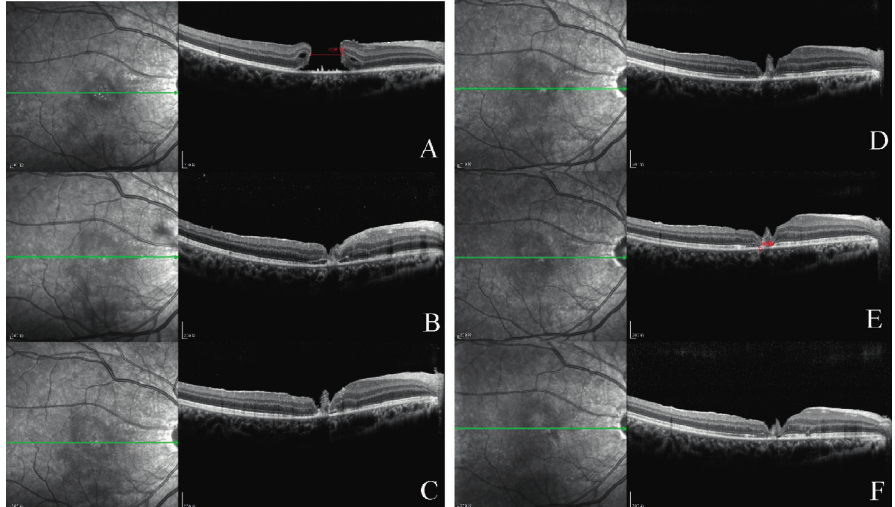
Figure 7: Case 15: a 16-year-old male patient with macular holes closed by vitrectomy. The patient sustained blunt trauma to the right eye from a fist. His BCVA was 20/500 at initial and improved 20/100 after surgery. (a) Preoperative OCT image showing FTMH with basal diameter of 1781 μ m. (b) OCT image 2 weeks after vitrectomy combined with ILM peeling and ILM flap and air tamponade. Retinal connection is visible, but part of the neuroretina and ellipsoid band has not regained integrity. OCT image (c) 1 month, (d) 4 months, (e) 9 months, and (f) 12 months